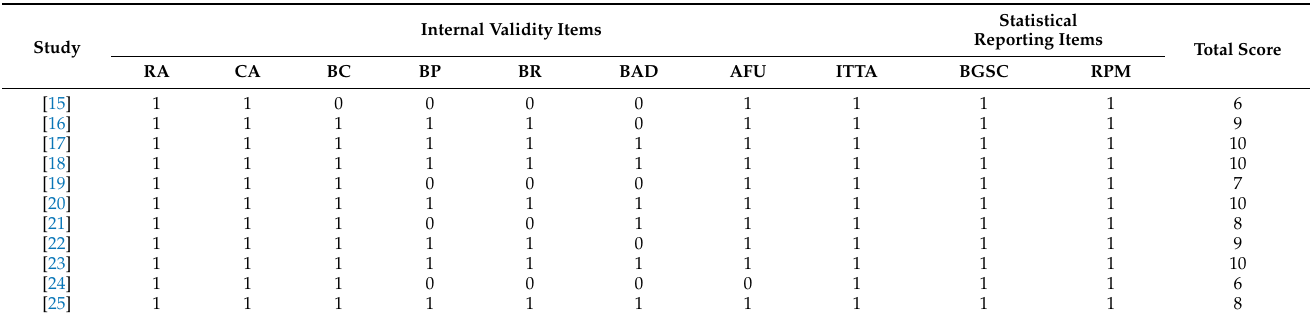
Table 1. Physiotherapy Evidence Database of the screened studies by full text.